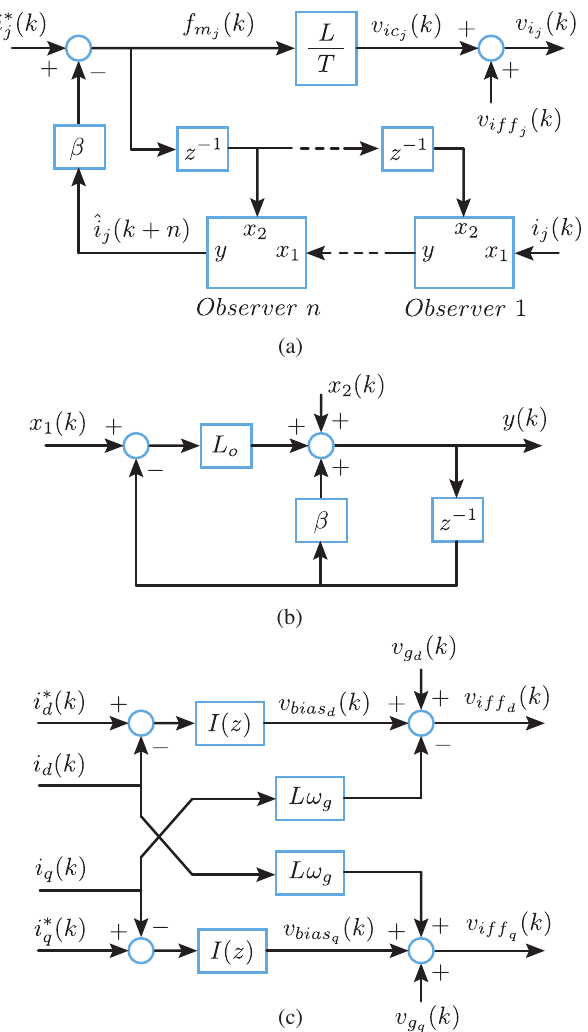
Figure 6. Integral Predictive Current Control (IPCC): ( a ) predictive control ( j = { d , q } ); ( b ) observer implementation for one sample forward prediction.; and ( c ) feed-forward term